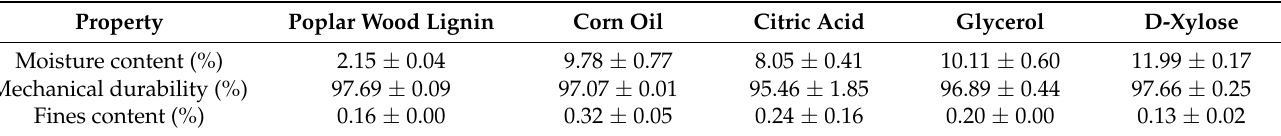
Table 7. Experimental results from an 8-day storage time at 2.0 ◦ C (condition 2) for pellets manufac- tured from poplar wood lignin and additives (scenario